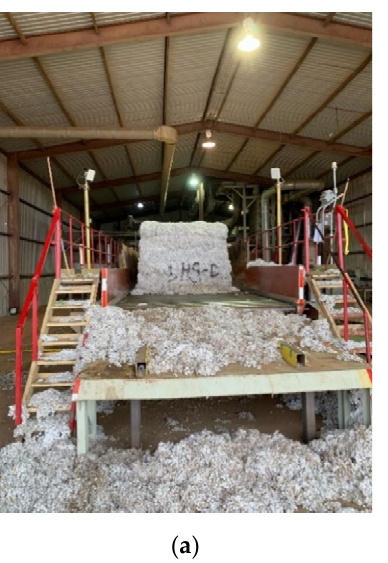
Figure 1. Module feeder floor system ( a ) and unloading of round module onto the module feeder floor ( b ) where the module accidentally tipped over trapping plastic underneath it. Whenever this situation occurred, the gin crew wasn’t always able to remove all of the plastic before it went on into the gin.